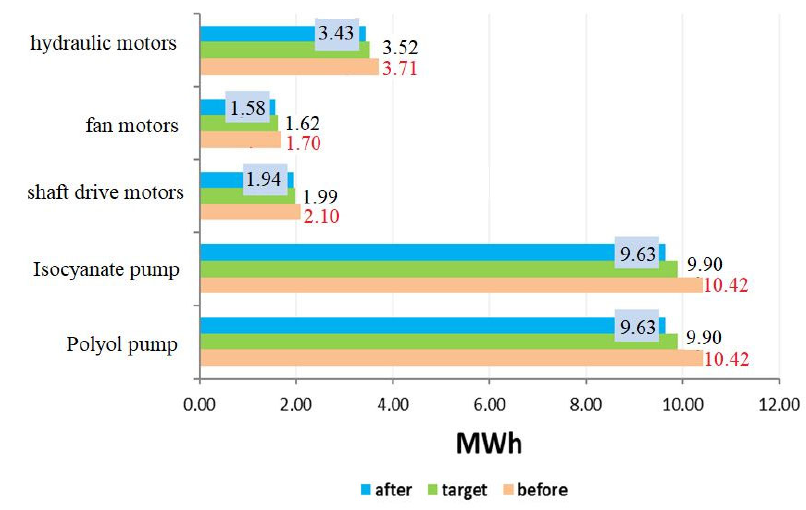
Figure 12. Energy consumption frame.